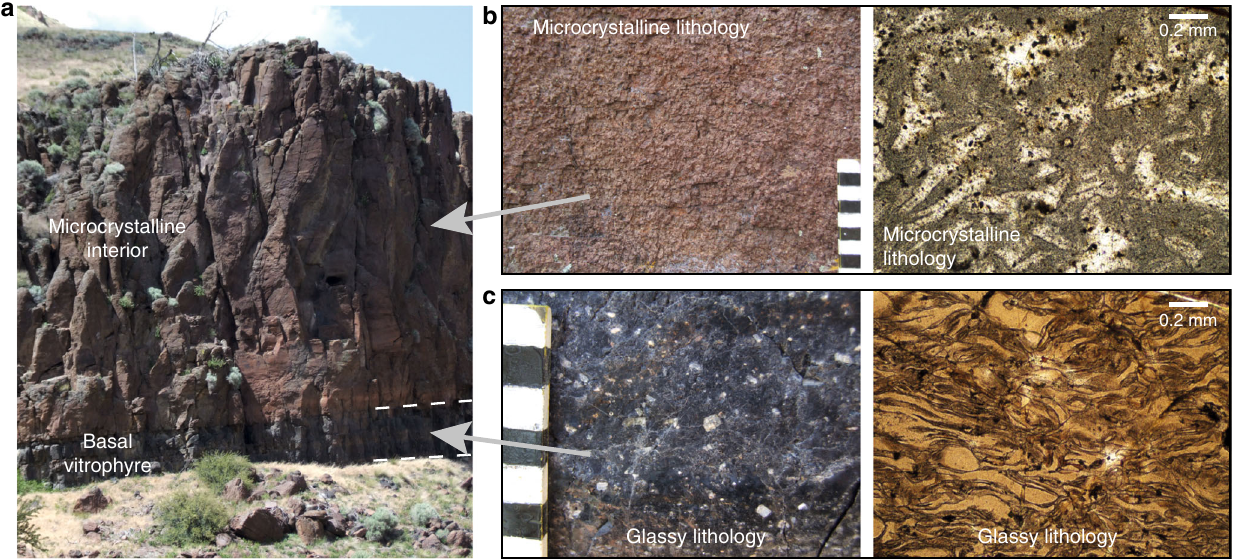
Fig. 1 Typical variability of groundmass crystallinity in high-grade welded ignimbrites. Glassy portions of the deposits ( a , c ) are preserved at the rapidly cooled upper and basal contacts while the slowly cooled central portions of the deposit are characterised by microcrystalline groundmass ( a , b ). Divisions on ruler are 1 cm, outcrop height ~15